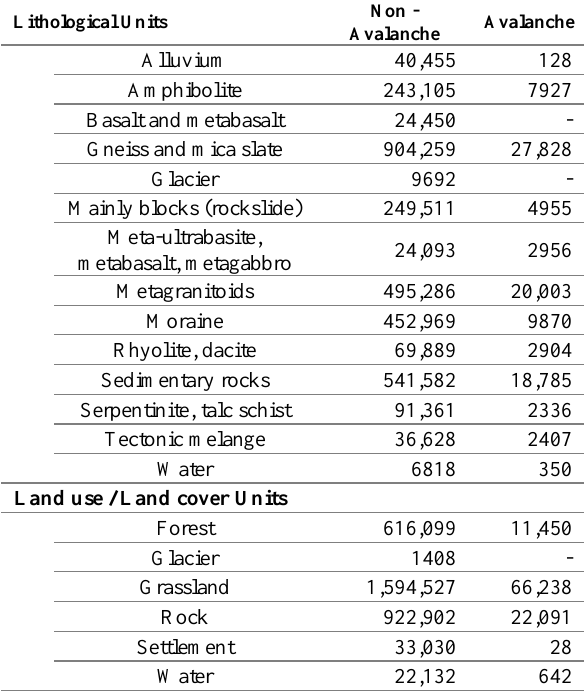
Table 1. The pixel counts of categorical